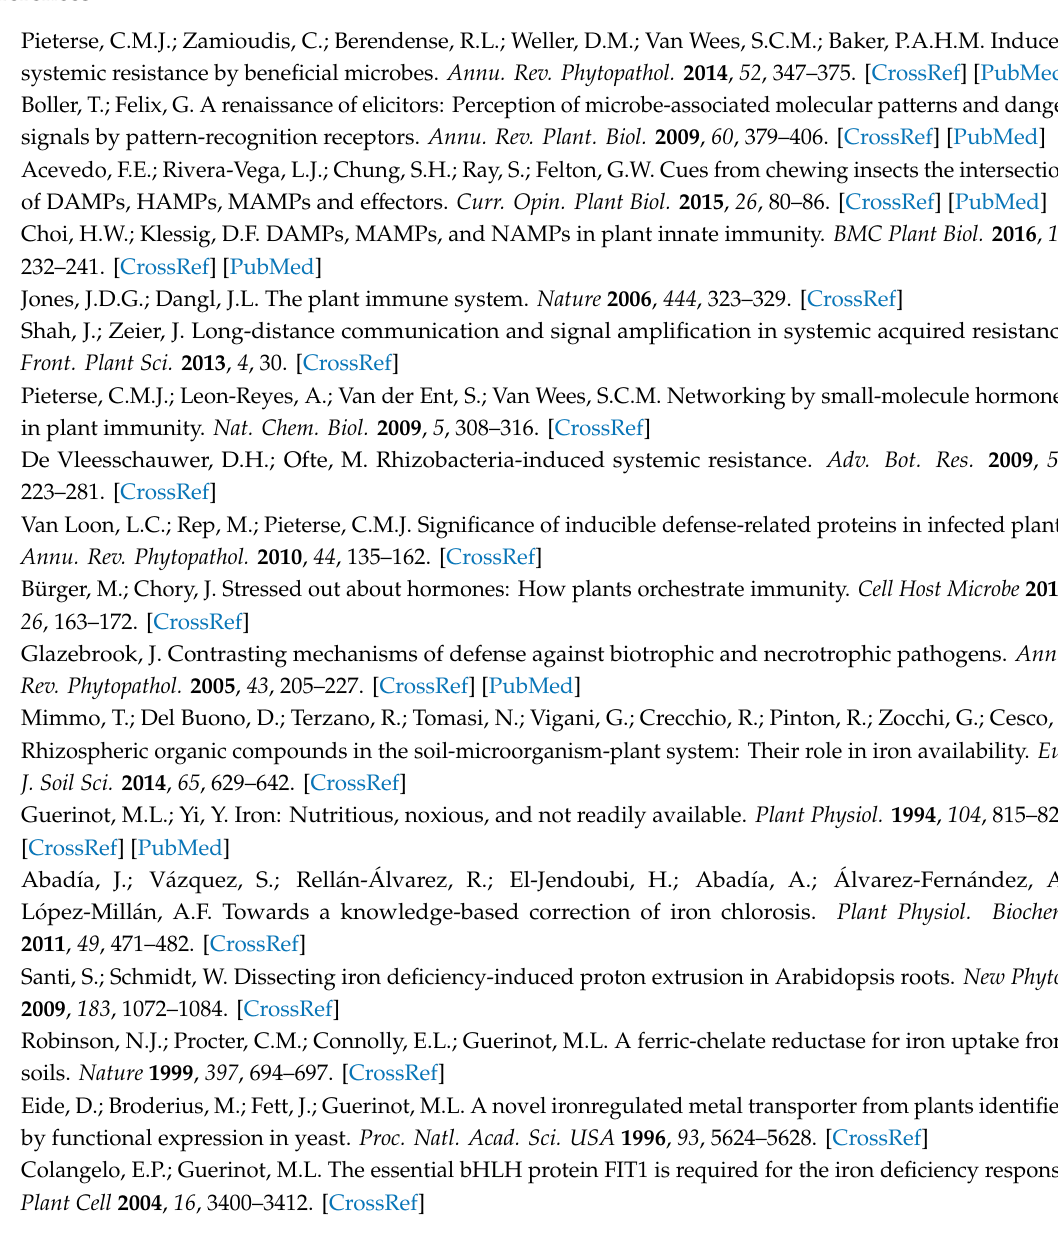
on Medicago truncatula trifoliate leaf number, Figure S4: Time kinetics of MtFIT gene expression, Figure S5: E ff ect of N , N -dimethylhexadecylamine (DMHDA) and Pseudomonas syringae or Botrytis cinerea infection on Medicago truncatula trifoliate leaf number, Figure S6: Representative images of RNA samples run on 1% agarose gel, Figure S7: Dissociation curves produced by RT-qPCR amplicons of genes listed in Table S1, Table S1: Genes identified in the present study, Table S2: Ratio of absorbance at 260 nm to absorbance at 280 nm of RNA samples used in the RT-qPCR measurements, Table S3: List of oligonucleotides employed in